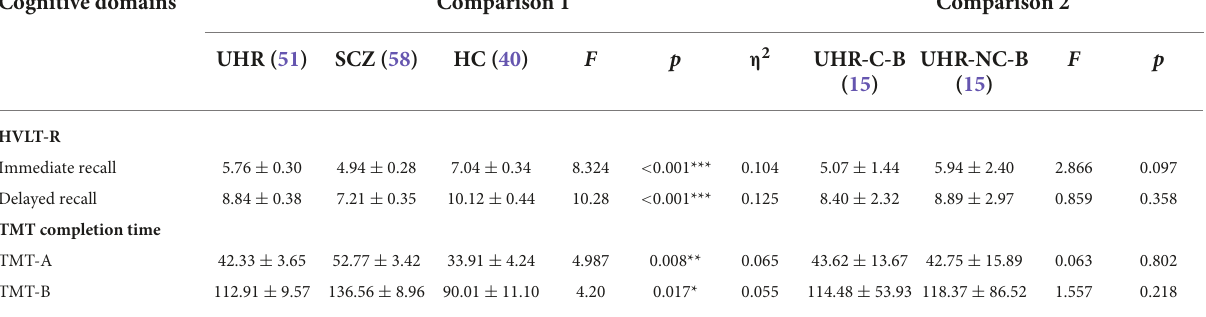
TABLE 3 Comparison of cognitive domains.